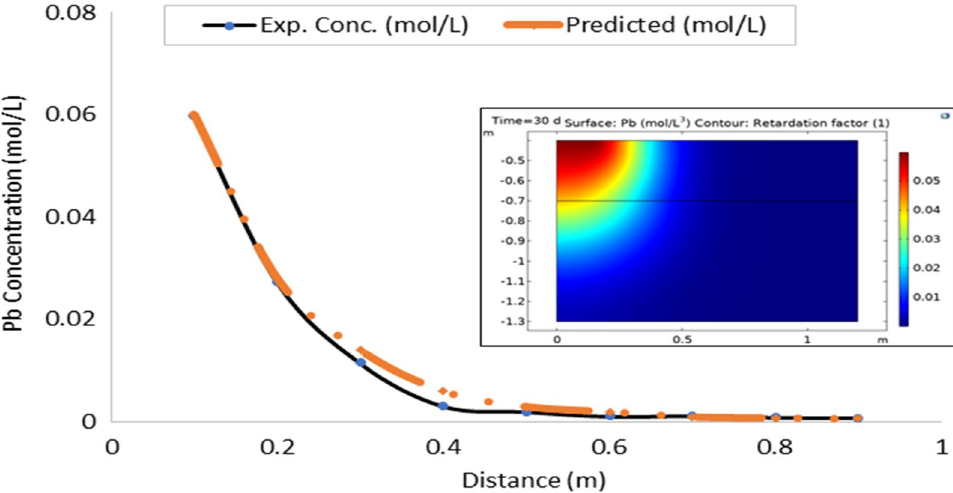
Figure 13. Pb transport in dumpsite soil of the study area.